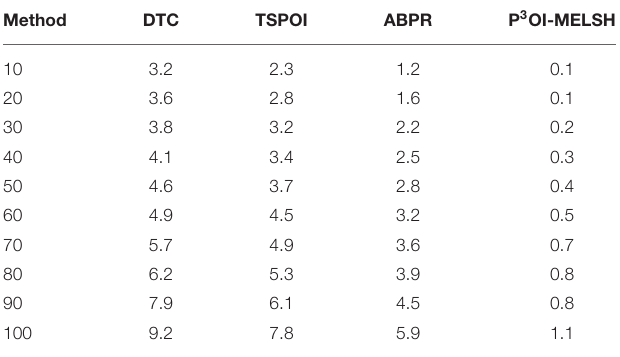
TABLE 4 | Running time comparison with different methods (unit/ms). Method